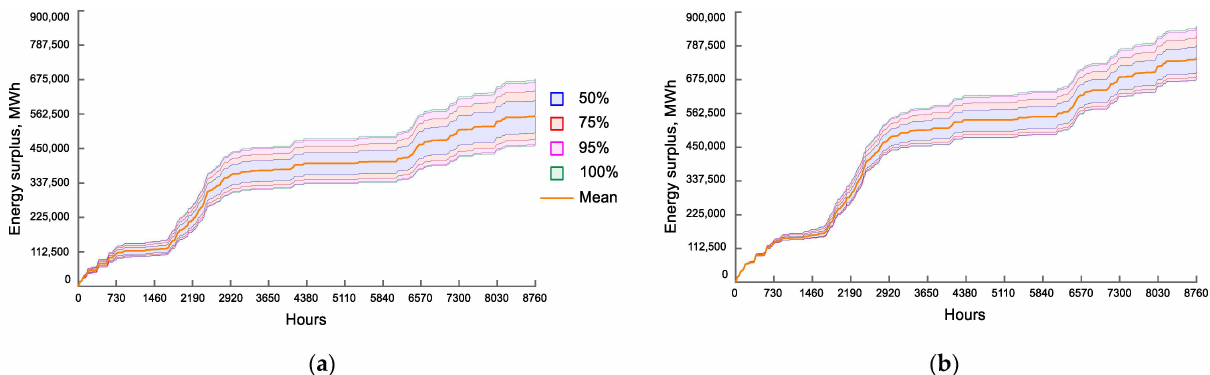
Figure 19. Sensitivity analyses for shiftable load changes impact the surplus power in case of ( a ) aggregator (RES) and ( b ) aggregator (hours) in Scenario